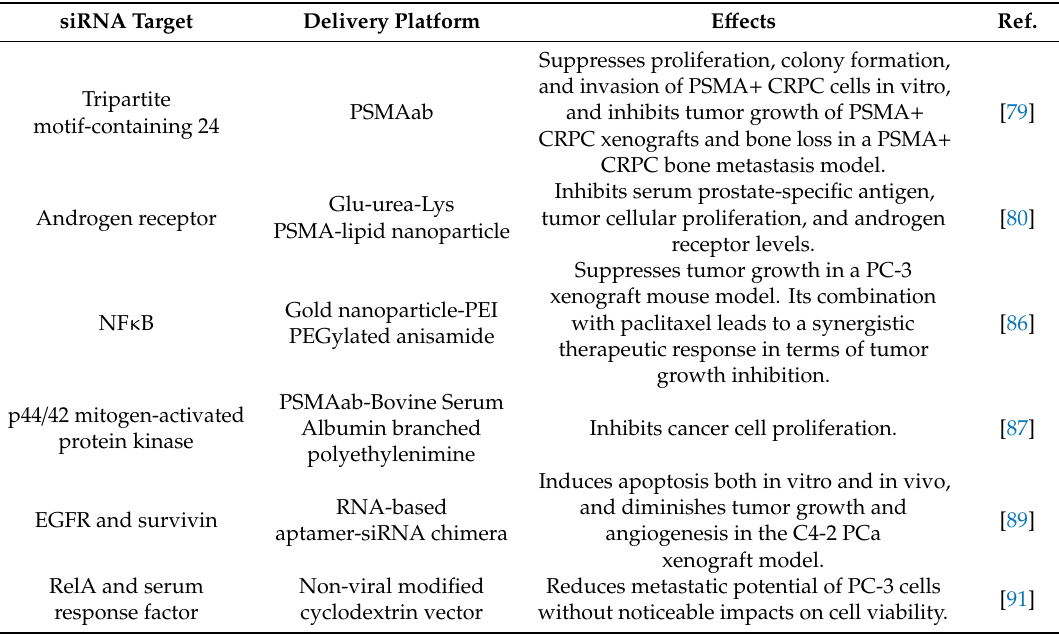
Table 2. siRNA delivery